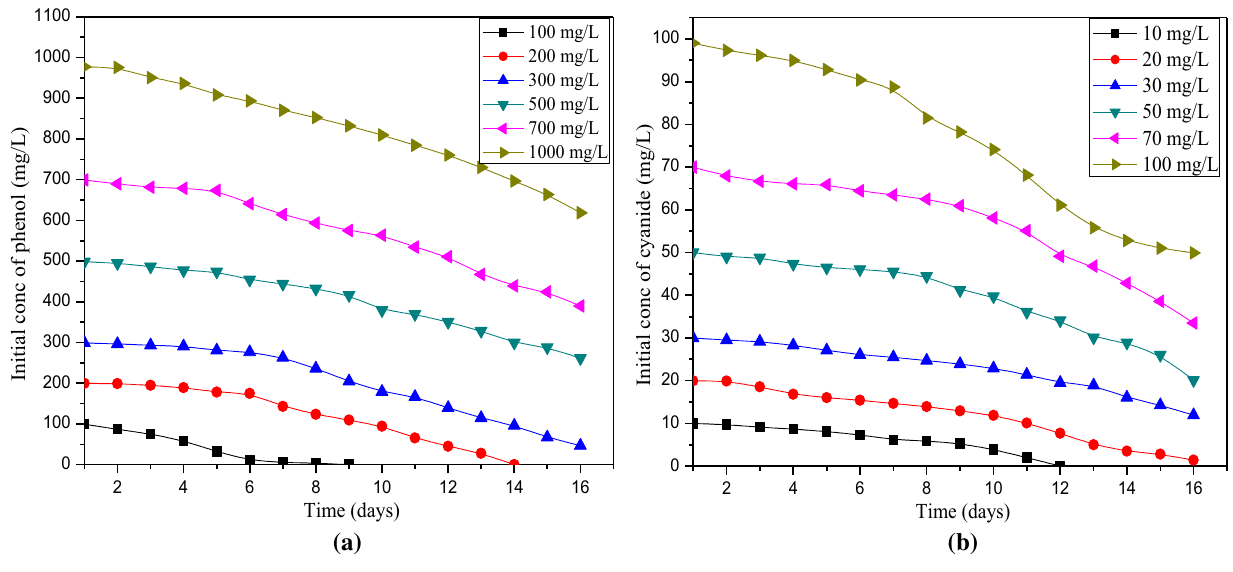
Fig. 9 Effect of initial concentration on removal of phenol and cyanide from binary component synthetic/simulated wastewater by Eichhornia crassipes a phenol b cynaide. (Reference operating conditions: Initial pH 8, Temperature 30 °C)